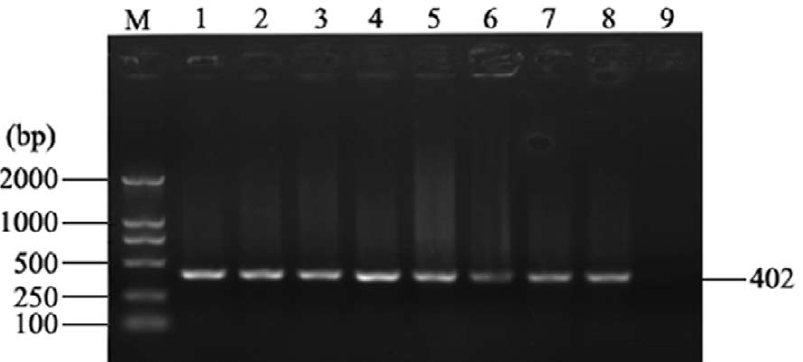
Figure 3. Verifying the accuracy of dot-blot hybridization. Lane M, DL 2000 DNA marker; lane 1 to 3, DNAs from spleens of the diseased broiler breeders; lane 4 and 5, DNAs from spleens of the 1 day old commercial chickens; lane 6, DNA from CEF inoculated with MD-CVI988/Rispens vaccine; lane 7, DNA from CEF inoculated with ND-LaSota + IB-H120 vaccine; lane 8, DNA from CEF inoculated with strain SNV of REV; lane 9, no template.